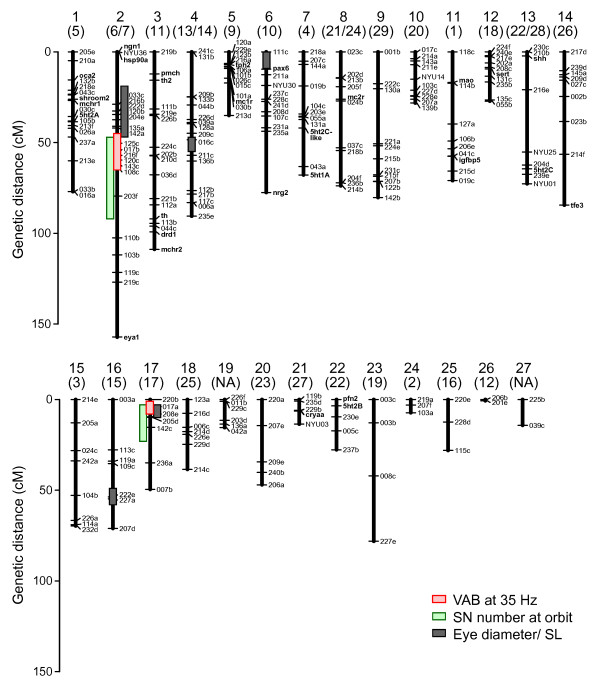
Astyanax mexicanus genetic linkage map from a Texas surface fish × Pachón cavefish cross. The names of the genomic markers are indicated at the right of each linkage group. LG ids for this cross are shown at the top with LG ids corresponding to the numbering scheme of Protas et al. [23] made from the F2 progeny of Mexican surface fish × Pachón cavefish cross shown in parentheses. NA indicates that there is no homologous linkage group in Protas et al. [23]. The bars denote Bayesian credible intervals with probability coverage as 0.95. New genes placed on the map in this study were the 5-hydroxytryptamine (serotonin) receptors (5ht1A, 5ht2A, 5ht2B, 5ht2C, 5ht2C_like), dopamine receptor D1 (drd1), eyes absent homolog 1 (eya1), monoamine oxidase (mao); melanin-concentrating hormone receptor 2 (mchr2), neurogenin 1 (ngn1), neuregulin 2 (nrg2); pro-melanin concentrating hormone (pmch); profilin 2 (pfn2); serotonin transporter (sert); tyrosine hydroxylase 1 and 2 (th, th2); and tryptophan hydroxylase 2 (tph2). Other genes (cryaa, hsp90a, igfbp5, mc1r, mc2r, mch1r, oca2, pax6, shhA, shroom2, tfe3) were genotyped and mapped as in previous studies [7,22,34].